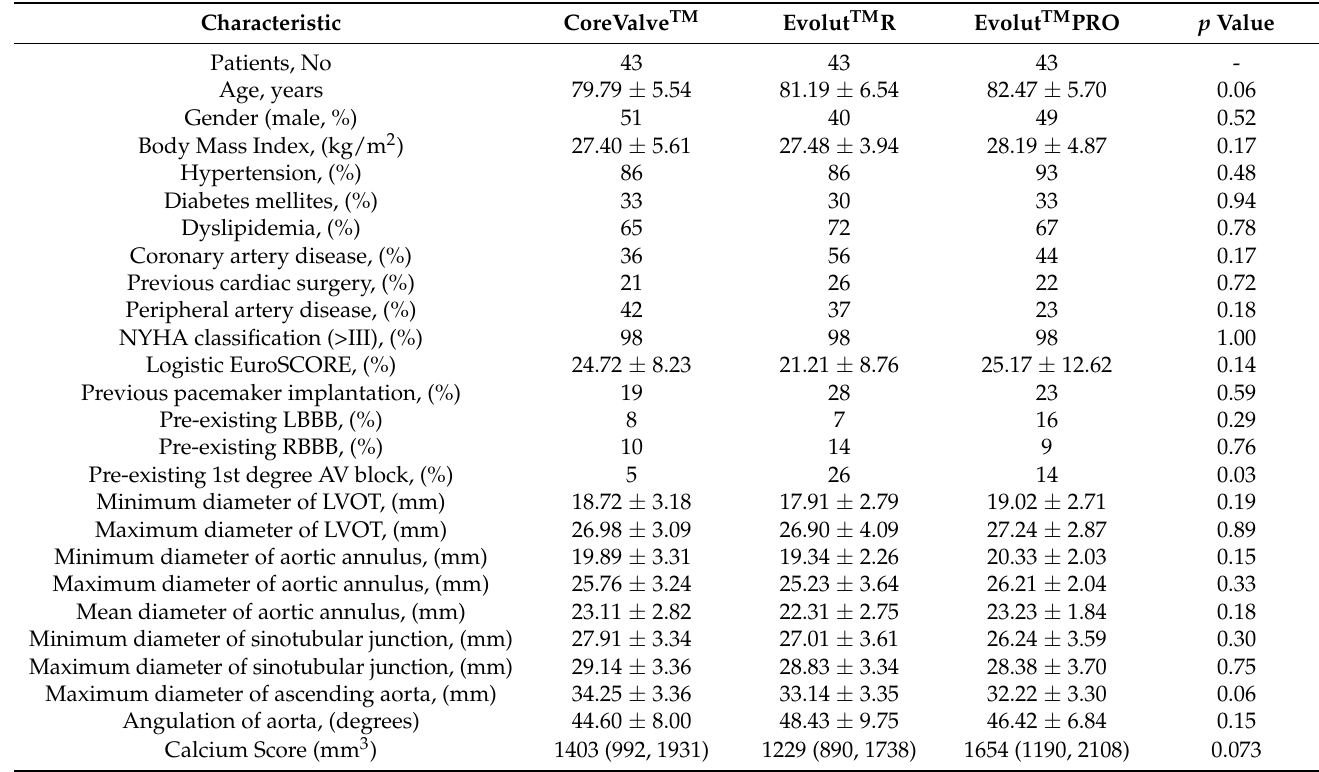
Table 1. Baseline characteristics of study